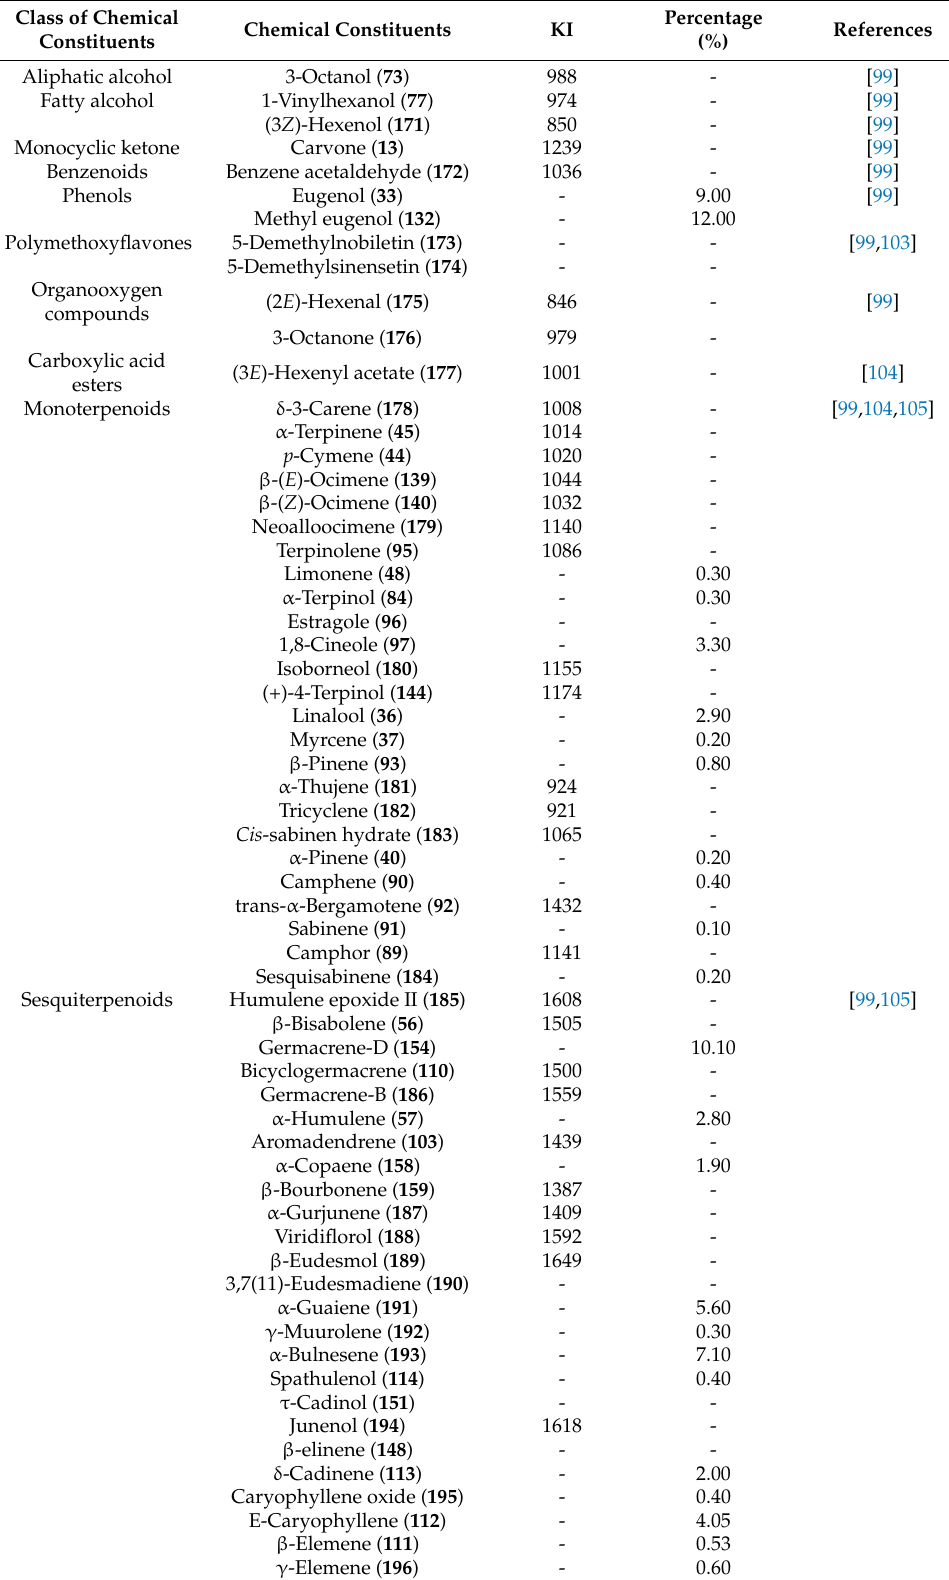
Table 4. The chemical constituents of O. campechianum